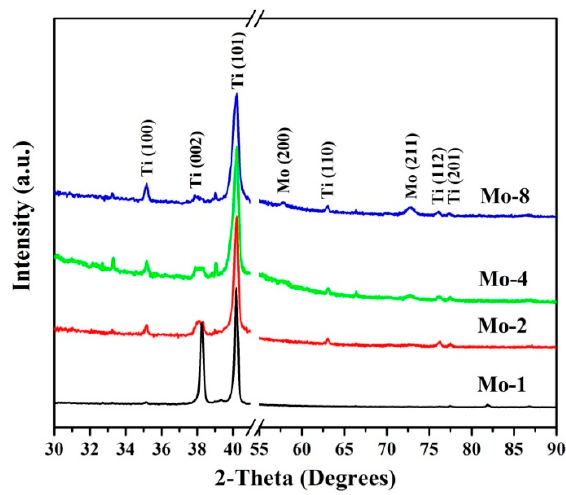
Figure 2. (Color online) X-ray diffraction (XRD) patterns of Si/Mo/Ti multilayer films with different Mo transition layer thicknesses. All four samples show strong Ti (101) preferred crystal orientation.